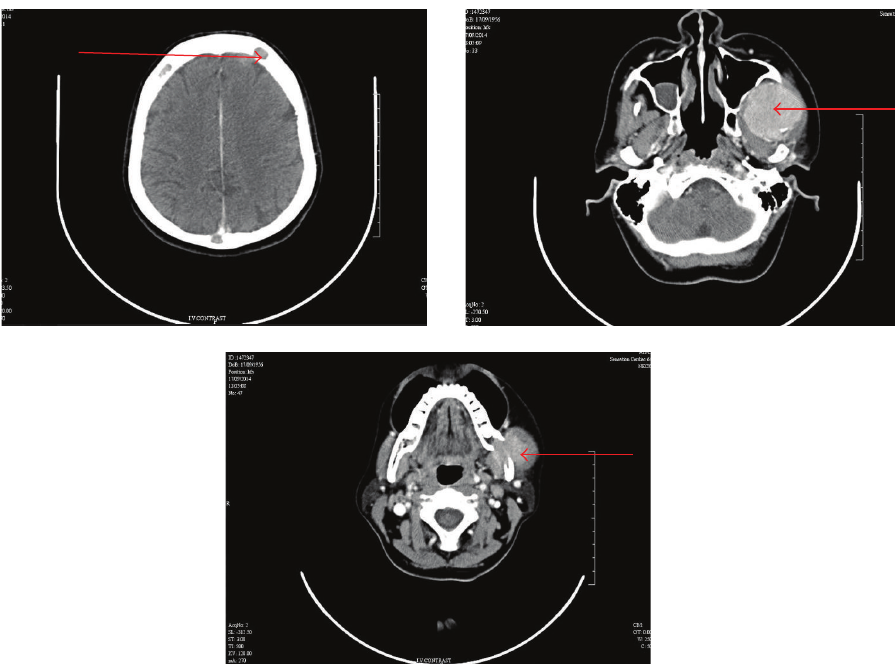
Figure 4: Axial CT section: Lytic lesion in left frontal bone and an expansile lytic and destructive lesion in the left ramus of the mandible involving the left infratemporal fossa and masseteric space and indenting the lateral wall of the left maxillary